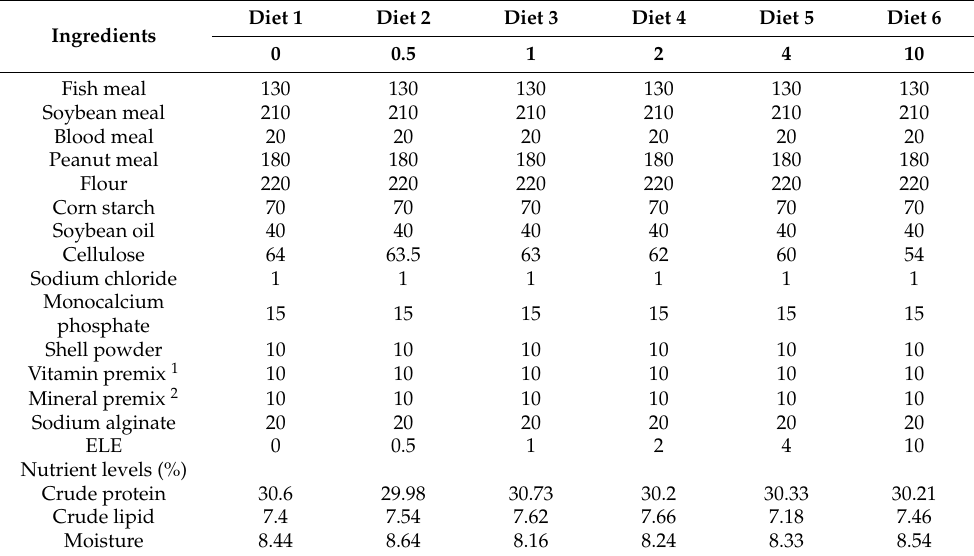
Table 1. Composition and nutrient level of experimental diets (g dw matter kg (dw) − 1 diet).